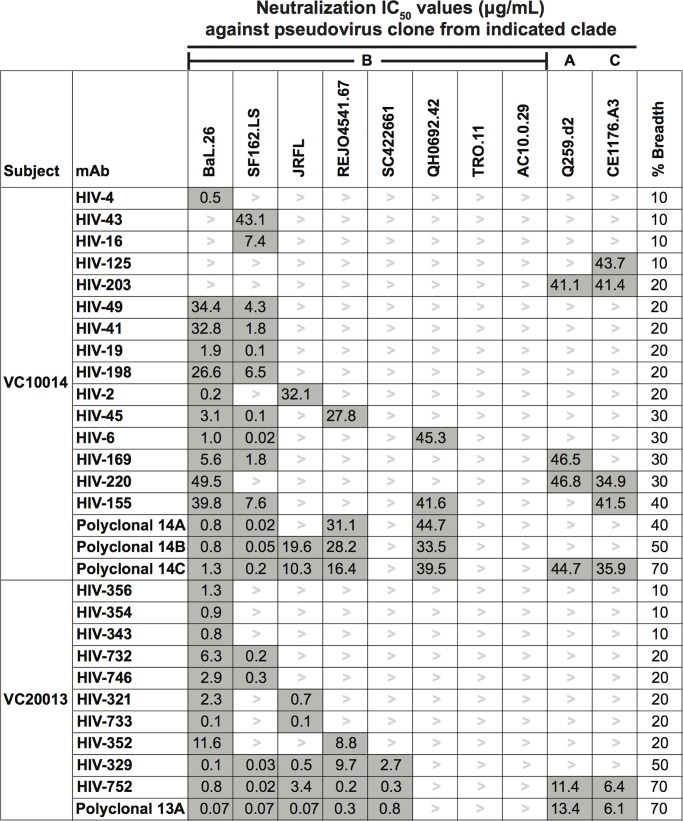
Heterologous neutralization breadth of HIV-1 mAbs.The neutralization phenotypes of HIV-1 mAbs and polyclonal mixtures from subjects VC10014 and VC20013 were determined using neutralization assays against heterologous pseudoviruses from the indicated clades. The values reported here shaded in grey are the IC50 values of neutralization as antibody concentration in μg/mL. The percent breadth reported is calculated by dividing the number of pseudoviruses for which an IC50 was recorded by the total number of pseudoviruses tested and multiplying by 100.